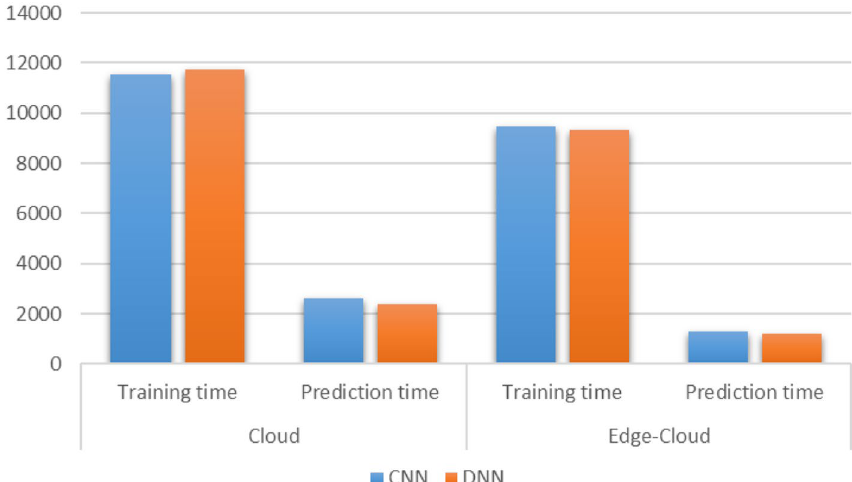
Fig. 14 Results of CNN and DNN models for cloud only and edge-cloud platform in terms of training and prediction times [time is mentioned in seconds and the smaller values are better than the larger